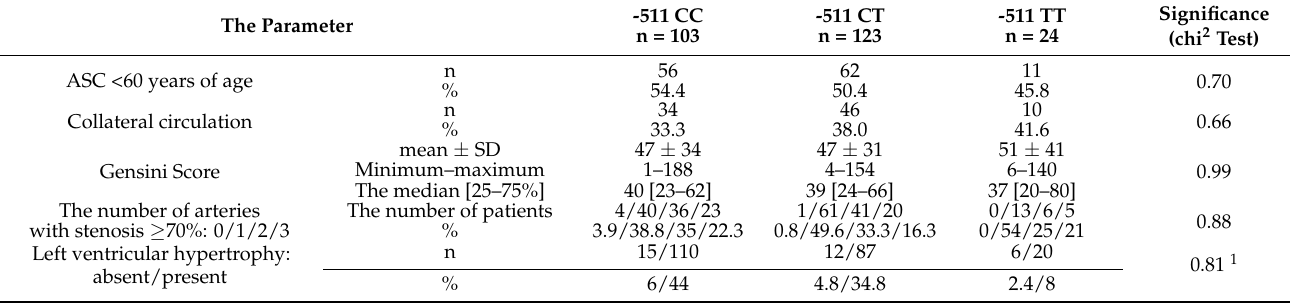
Table 8. The clinical, angiographic, and echocardiographic parameters according to the variant at locus -511. The